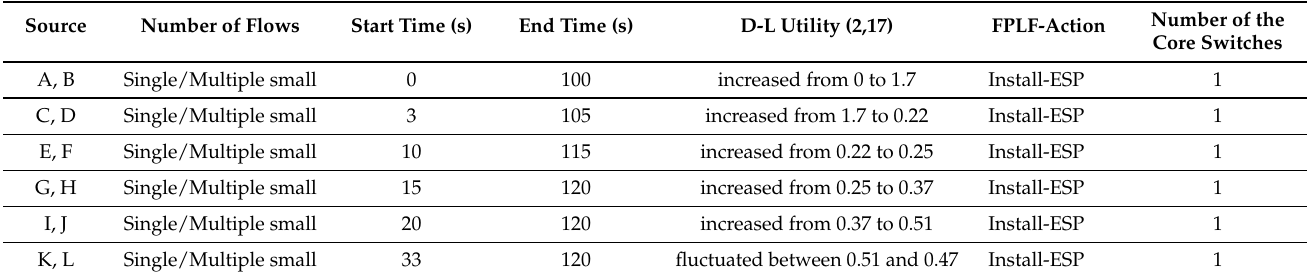
Table 4. Low traffic scenario events that were generated and had server P as the traffic’s destination.